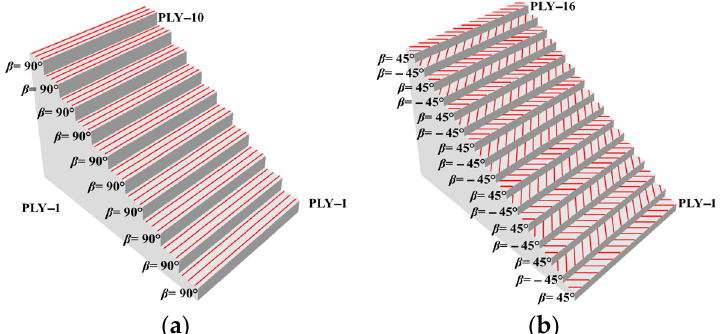
Figure 3. ( a ) Layer stacking sequence for the UD-90 set, and ( b ) layer stacking sequence for the SH-45 set; recreated according to [81].